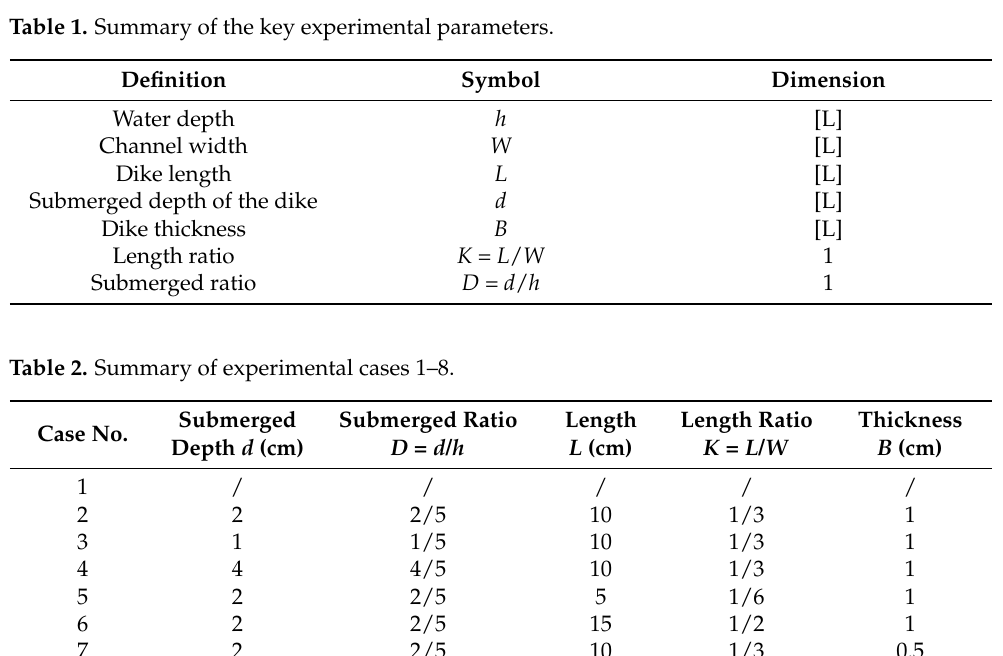
Table 1. Summary of the key experimental parameters.